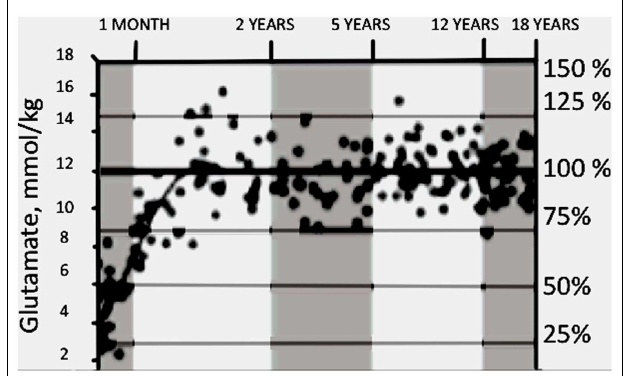
FIGURE 12 | Developmental changes in glutamate content in parietal/occipital gray matter measured by MRI in young children. On percentage scale 100% refers to ages between 2 and 18 years. From Blüml et al.